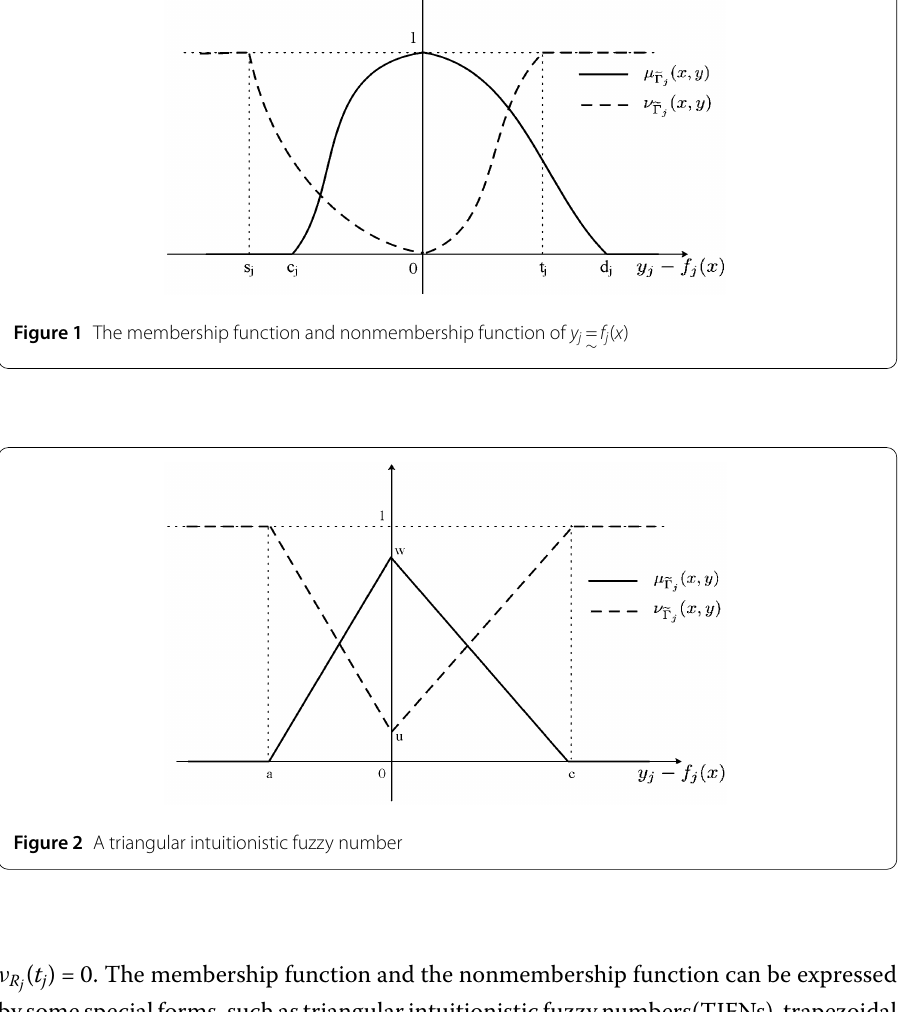
Figure 2 A triangular intuitionistic fuzzy